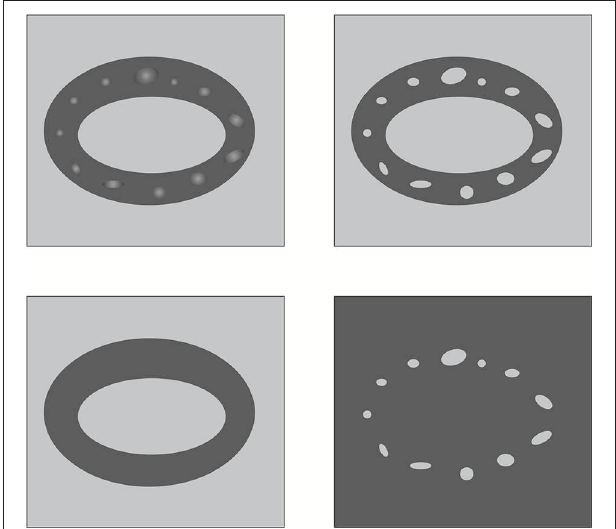
FIGURE 1 | Schematic representation of original data S (upper left), clustered data S cl (upper right), smoothed data S sm (bottom left), and data of inclusions S in (bottom right).